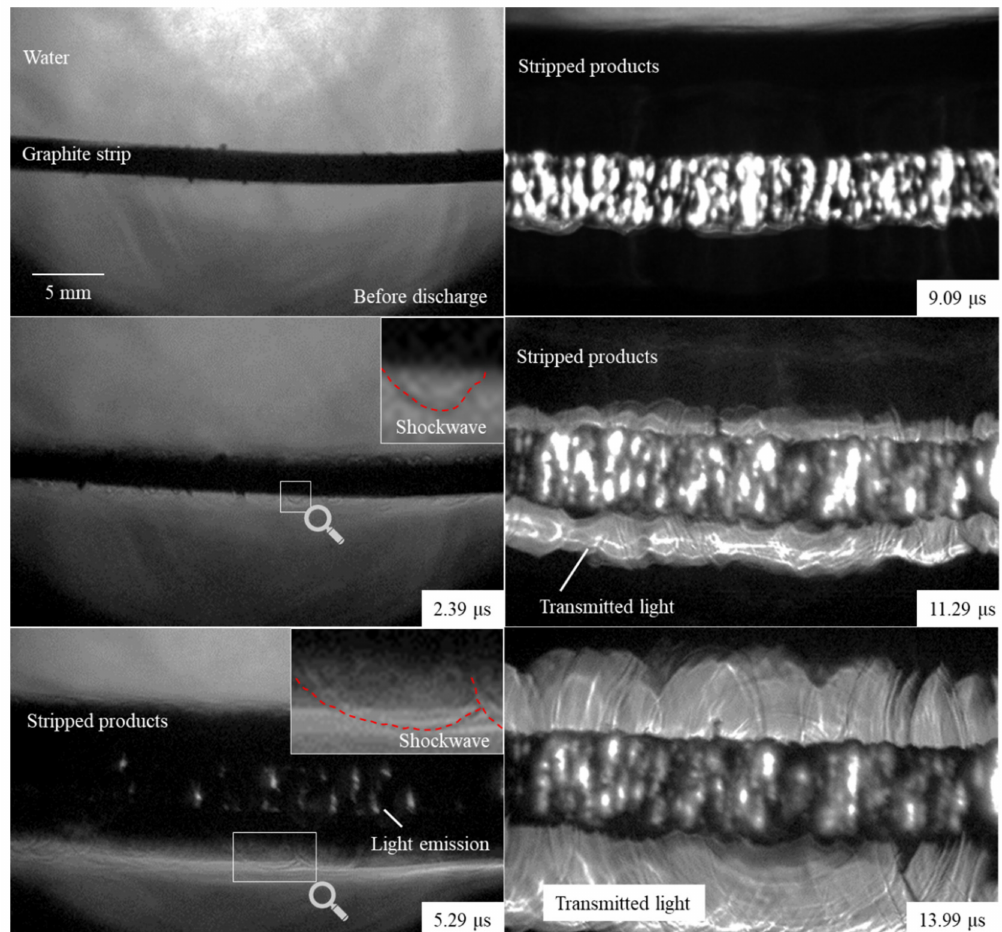
Figure 3. Images of an underwater explosion caused by the rapid heating of a graphite strip by pulsed